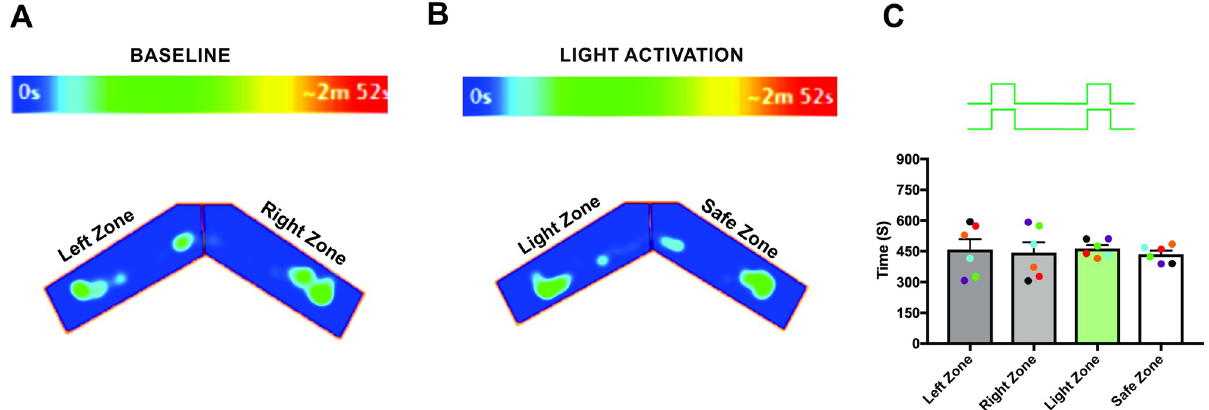
Fig 6. Green light stimulation did not activate the olfactory system of OMP-ChIEF mice. A, B, Heat-map of mouse position during baseline (A) and green light stimulation (B). C, Average amount of time spent in each zone during green light stimulation (n = 6).